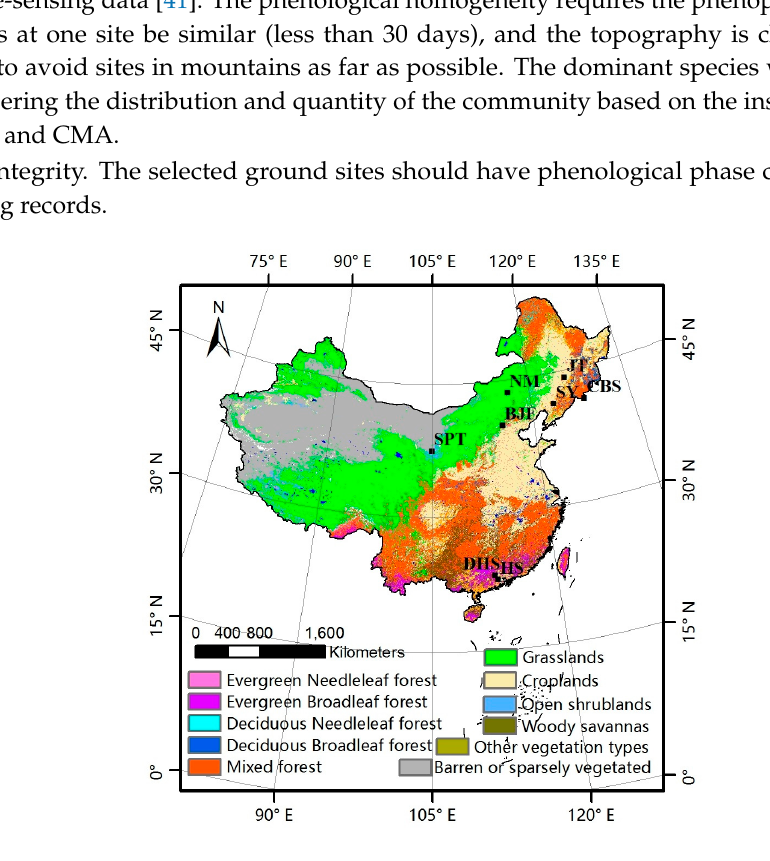
Figure 2. Land cover map and phenological observation sites distribution in China.